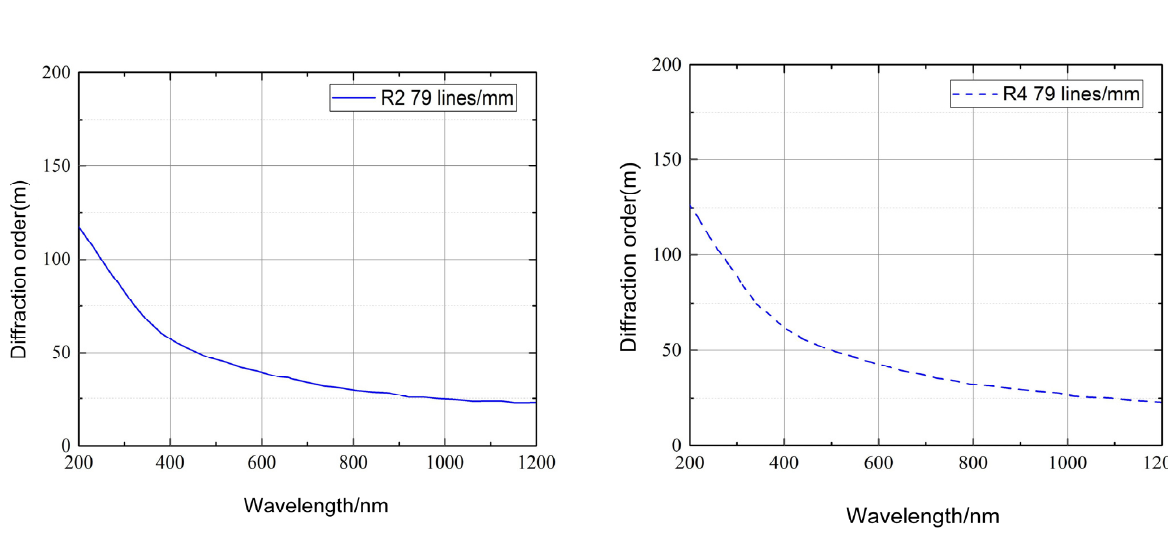
Table 4. The wavelengths and free spectral ranges of multiple